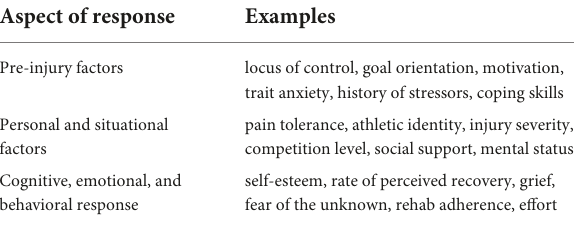
TABLE 1 Integrated sport injury